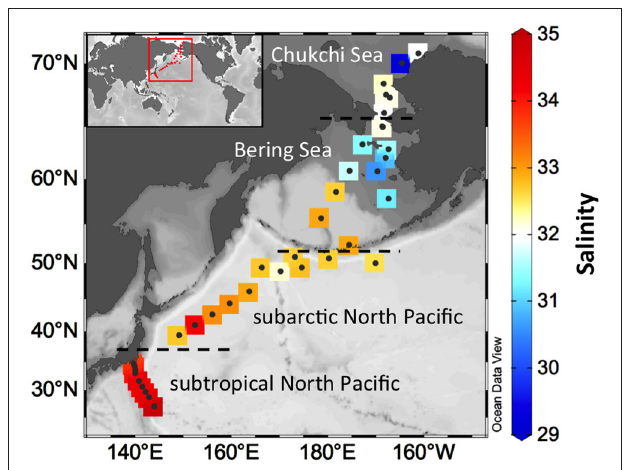
FIGURE 1 | Map of the study area showing sampling sites with observed salinity.